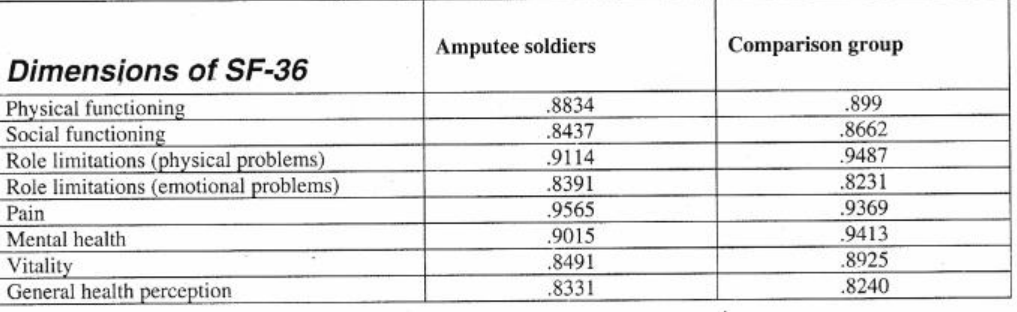
Table 7: Internal consistency (Cronbach's alpha)of SF-36 amongamputeesand comparison group